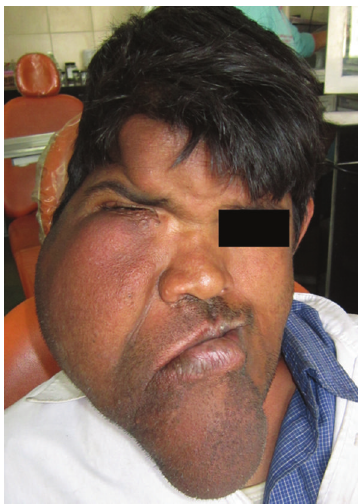
Figure 2: Occlusal view of the maxillary and mandibular dental casts showing macrodontia of the right side, midline shift to the left, along with granular surface of the right palatal mucosa.